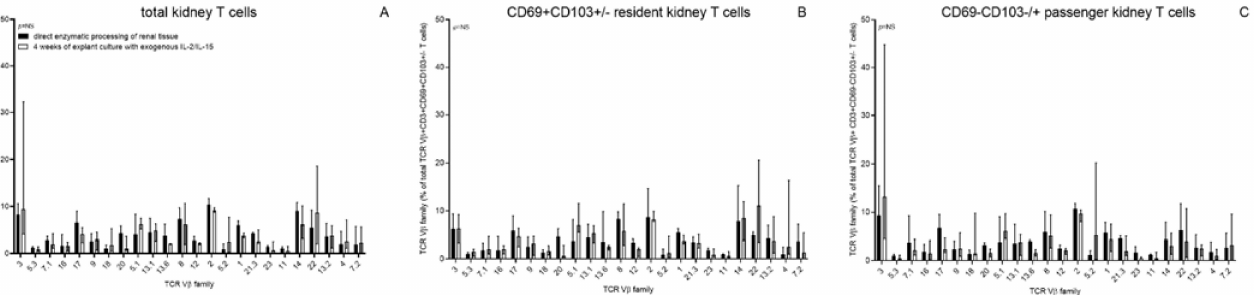
Figure 2. TCR V β repertoire T cells. The TCR V β repertoire was determined using the flow cytometry- based IOTest ® Beta Mark TCR Vbeta repertoire kit for T cells obtained following direct enzymatic dissociation of kidney tissue (closed bars) and compared to that of T cells harvested following four weeks of explant culture in the presence of exogenous IL-2 and IL-15 (open bars). Kidney tissue used was obtained from three nephrectomies and one transplantectomy. In ( A ), the repertoire for total kidney CD3+T cells is depicted, in ( B ), that of CD69+CD103+/ − resident kidney CD3+ T cells, whereas ( C ) depicts the CD69 − CD103+/ − passenger kidney CD3+ T cells. Bars represent median (IQ range) values for the 24 different TCR V β families expressed as a percentage of total TCR V β +